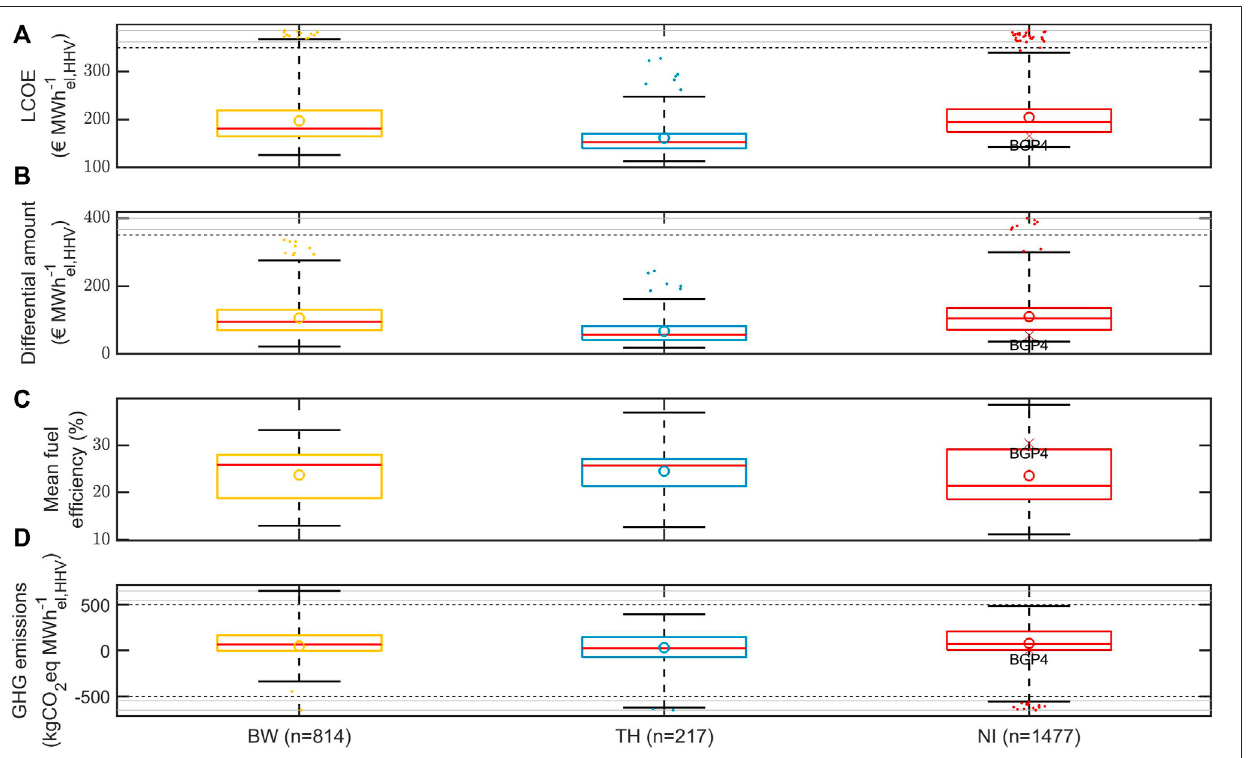
FIGURE 6 | Regional differences and distribution of key performance indicators (A – D) for “ Flex Base ” in the REF scenario; BGP4 is additionally marked; Boxplots with a whisker value of 2.5; Circle (cid:1) Mean value; Dots (cid:1) Outliers; LCOE (cid:1) Levelized cost of energy/electricity, GHG, Greenhouse gas; BW, Baden-Wuerttemberg; TH, Thuringia; NI, Lower